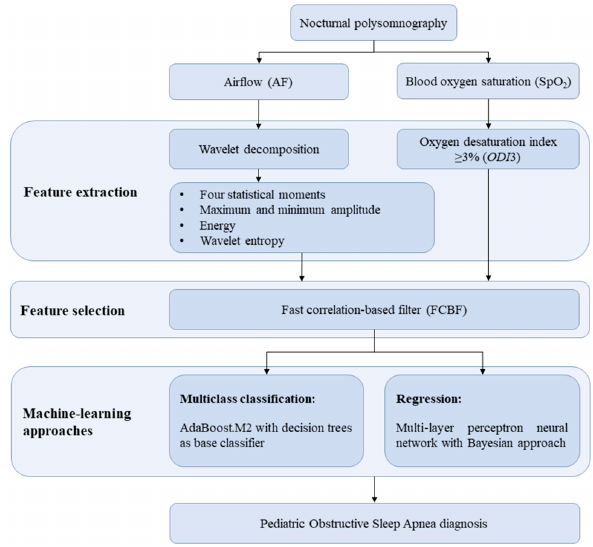
Figure 1. Scheme of the proposed methodology.